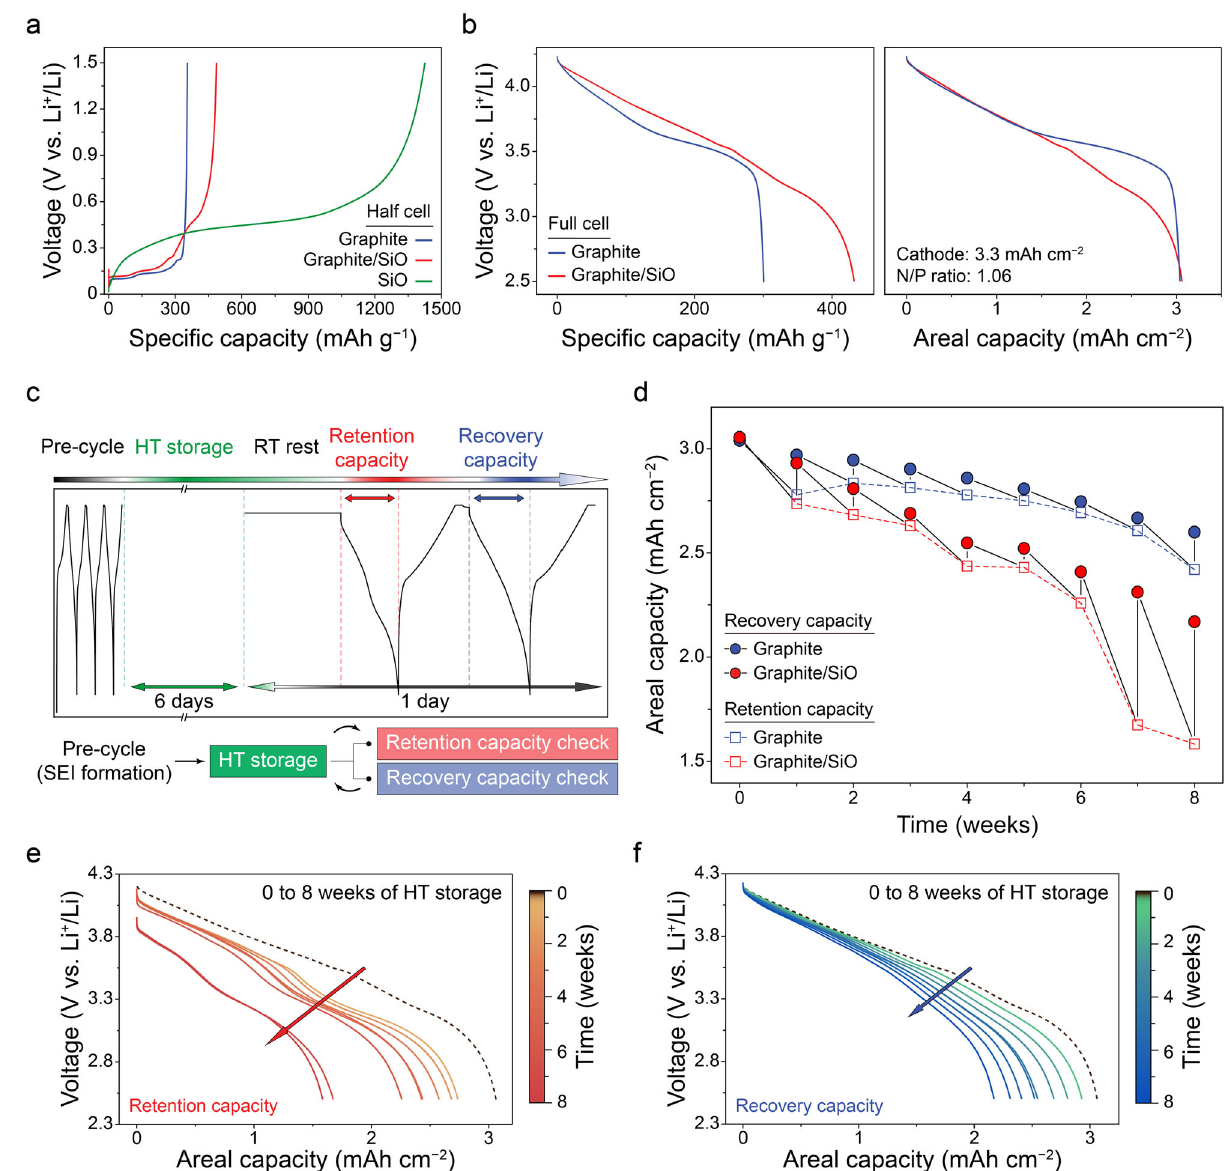
d Decay of retention and recovery capacities measured between periodic HT sto- rage for 8 weeks. The initial value (0th week) indicates 3rd discharge capacity. Corresponding discharge curve variations of e retention and f recovery capacities of graphite/SiO full cell showing capacity decay compared to the initial one (dashed